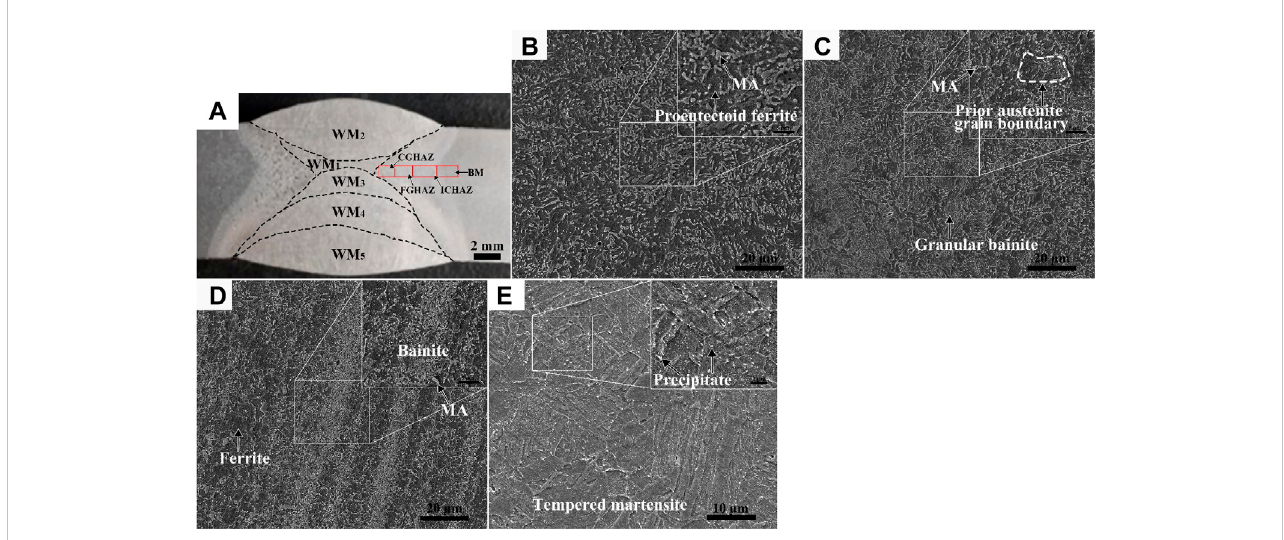
FIGURE 5 Macro location of each area of the HAZ (A) and SEM morphologies of the CGHAZ (B) , FGHAZ (C) , ICHAZ (D) , and BM (E) .